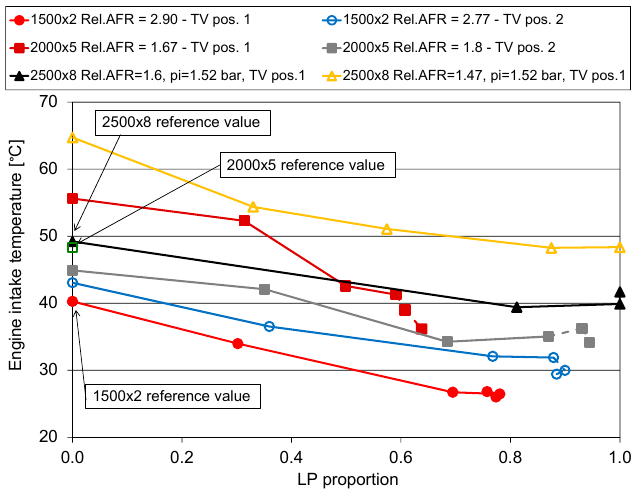
Figure 6. Engine intake temperature as a function of LP proportion in different operating modes.